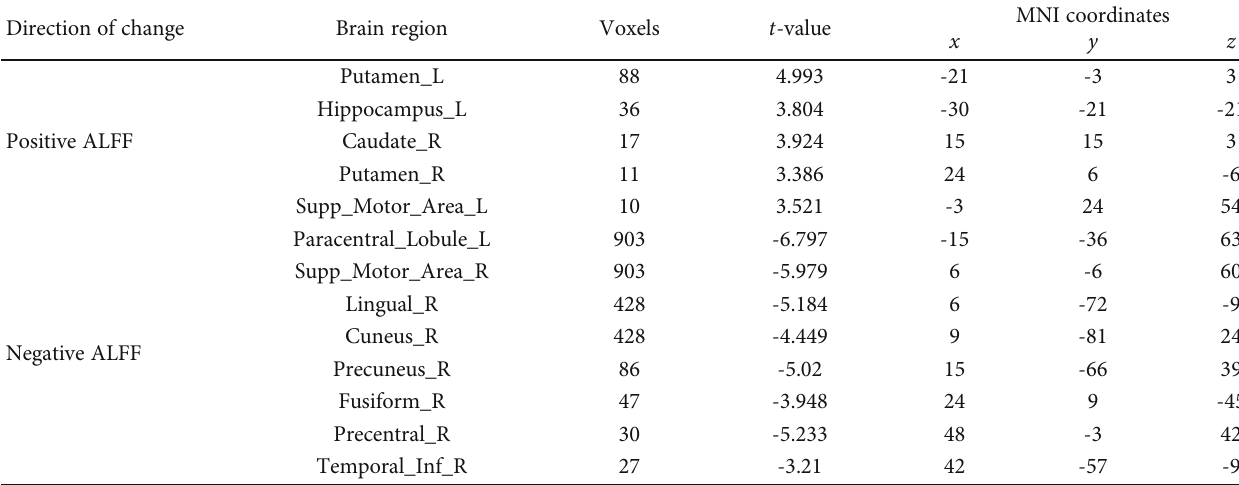
Table 3: Relative regional changes in ALFFs at 6 months ∗